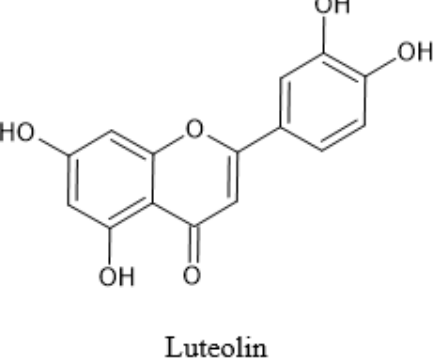
Figure 4. Structure of